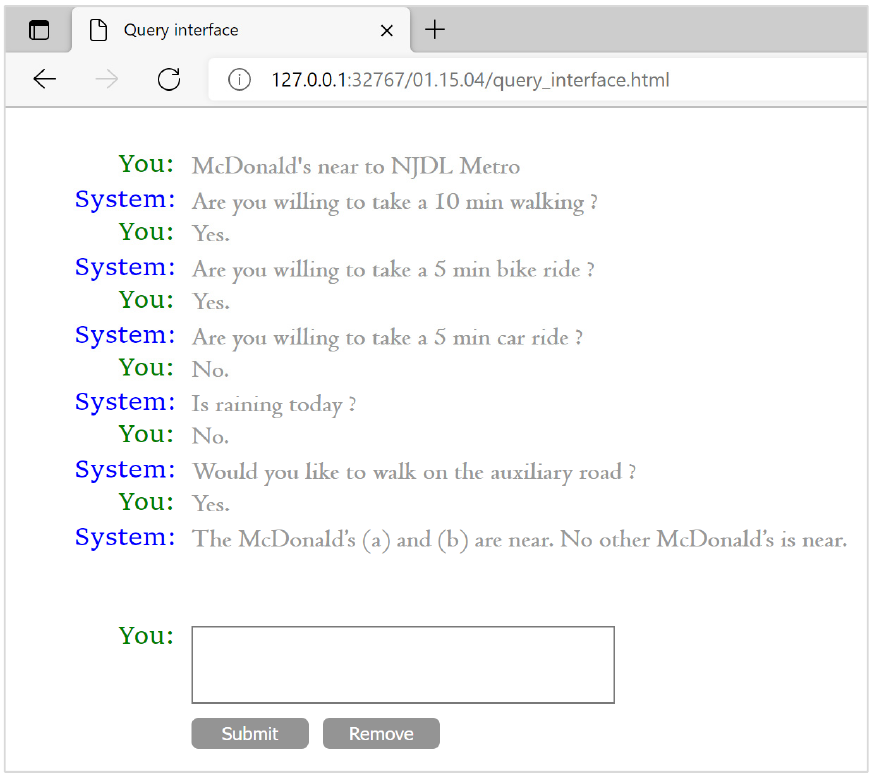
Figure 8. The contexts of single spatial assertion in Q&A system.